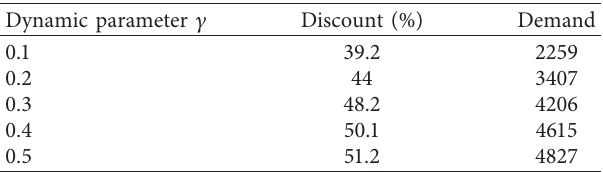
Table 8: Impact of